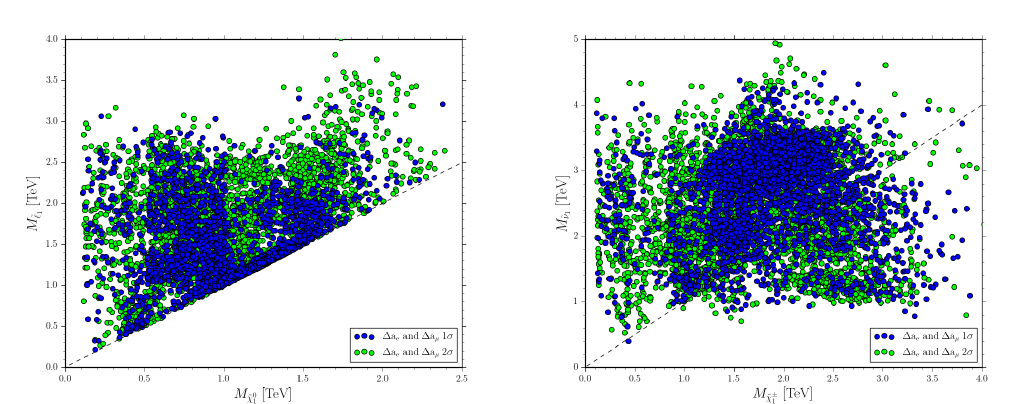
Figure 4 . Correlation between the choices of lightest neutralino-lightest slepton masses left and lightest chargino-lightest sneutrino masses right in order to obtain ∆ a circles), 2 σ (green circles) of their experimental values. All possible LSP scenarios are